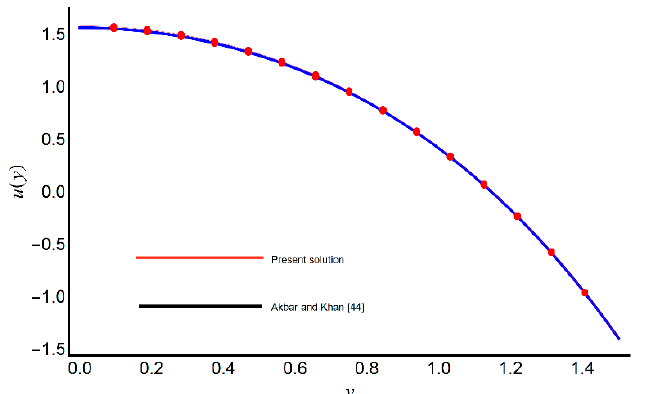
Figure 2. Comparison of velocity profiles by the present numerical scheme and the exact solution reported by [44].